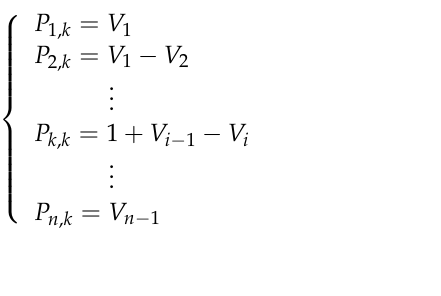
Figure 3. Calculation model of the FM principle. The calculation procedure of each constant coefficient in Equation (3) is detailed in Ref. [27]. According to Figure 3 and Equation (3), there are ( n − 1) unknown shear forces and ( n − 1) simultaneous equations for n slabs. In addition, the equation coefficient δ ij needs to be recalculated to obtain the TLD for each slab. Then, a system of linear equations must be solved again to derive each unknown shear force. It can be seen that using the FM principle to calculate the TLD of articulated slab bridges is tedious and requires substantial equations. After calculating V j ( j = 1, 2, . . . , n − 1), the resultant vertical force on each slab can be obtained through their free body diagram. In case of the slab k subjected to the unit vertical force, this is exactly the TLD of each slab in the whole